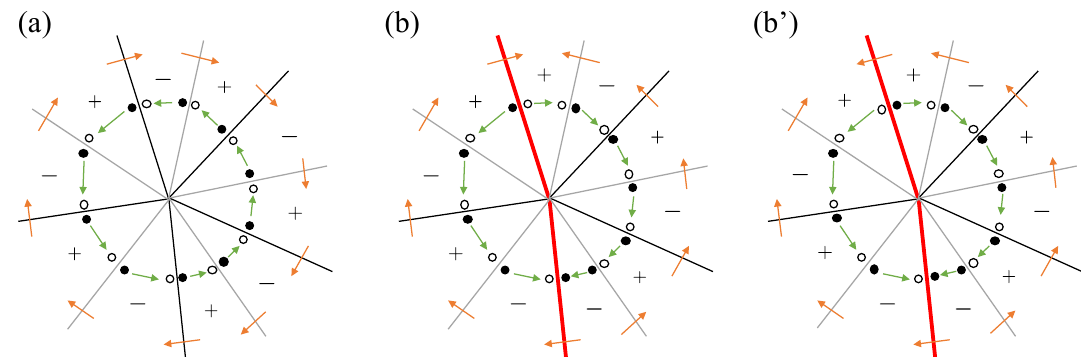
Figure 3 . When (cid:21) ( v ) = 1 on a single ( d (cid:0) 2) simplex v , Grassmann variables on ( d (cid:0) 1)-simplices sur- rounding v are counted in the integral. In the expression of the integral, we encounter (cid:6) d# 2 i d# 2 i +1 measure factors from ( d (cid:0) 1)-simplices, and (cid:6) # 2 i +1 # 2 i +2 integrand factors from d -simplices. The sign (cid:6) from the measure (resp. integrand) is expressed by the orange (resp. green) arrow. For instance, the arrow is directed from # 2 i to # 2 i +1 if we have a + sign on the measure, otherwise directed in the opposite direction. (a): if v is away from the orientation reversing wall, we can see that all the signs from the measure share the same sign. We can also check that signs from the integrand have the same sign. In such a situation, we have (cid:27) ( (cid:14)(cid:21) ) = (cid:0) 1. (b): if v is placed on the orientation reversing wall (red thick line), we have to (cid:13)ip the direction of all arrows on one side of the wall. The total number of (cid:13)ipped arrows is odd; odd number of orange arrows and even number of green arrows. Thus, the value of the integral in (b) has the opposite sign from that of (a). Hence, we have (cid:27) ( (cid:14)(cid:21) ) = +1, when the two Grassmann variables attached on one side of the wall have di(cid:11)erent colors. (b’): on the other hand, we have (cid:27) ( (cid:14)(cid:21) ) = (cid:0) 1, when the two Grassmann variables attached on one side of the wall have the same